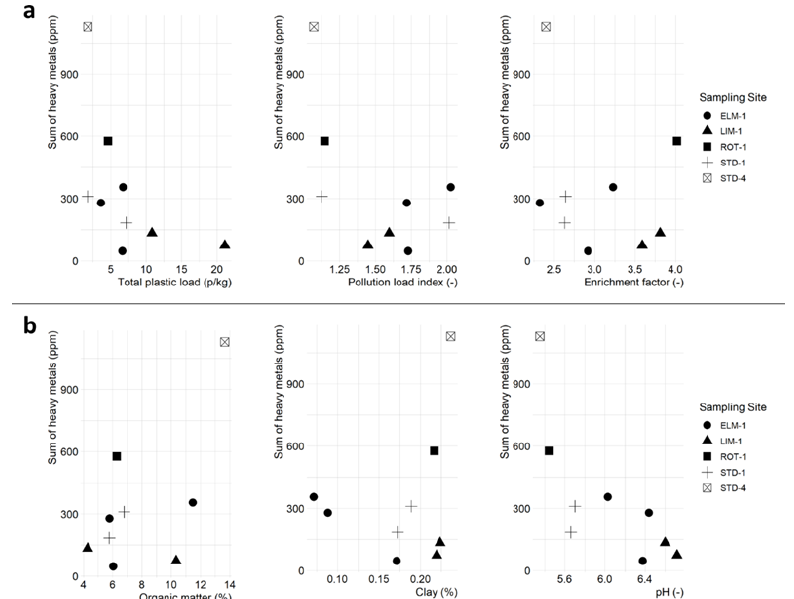
Figure A1. Comparison of sum of heavy metals (ppm) extracted from macroplastic particles with ( a ) total plastic concentrations and pollution indices (PLI and EF) of the respective soil sample and ( b ) floodplain soil properties of the respective soil sample per sampling site.